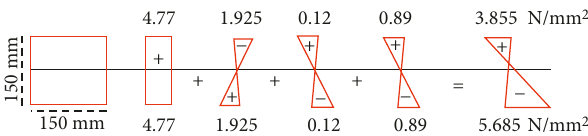
Figure 2: Resultant stress in concrete.